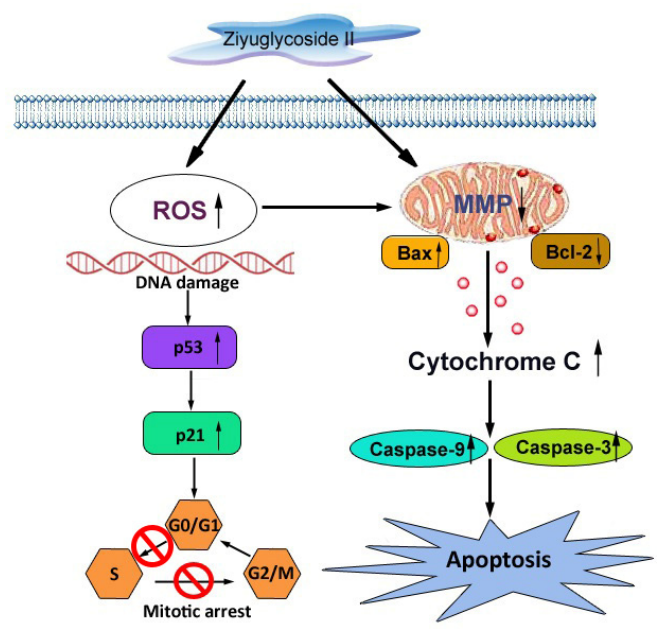
Figure 8. The proposed mechanisms for ziyuglycoside II induced cell cycle arrest and apoptosis in MDA-MB-435 cells. Ziyuglycoside II increased the accumulation of ROS, which resulted in the up-regulated expression of p53, p21 and Bax but down regulated expression of Bcl-2 in MDA-MB-435 cells. Consequently, the mitochondrial membrane potential (MMP) was reduced and then accelerated the release of cytochrome c into cytoplasm leading to the apoptosis of MDA-MB-435 cells via the caspase-3 and caspase-9 dependent